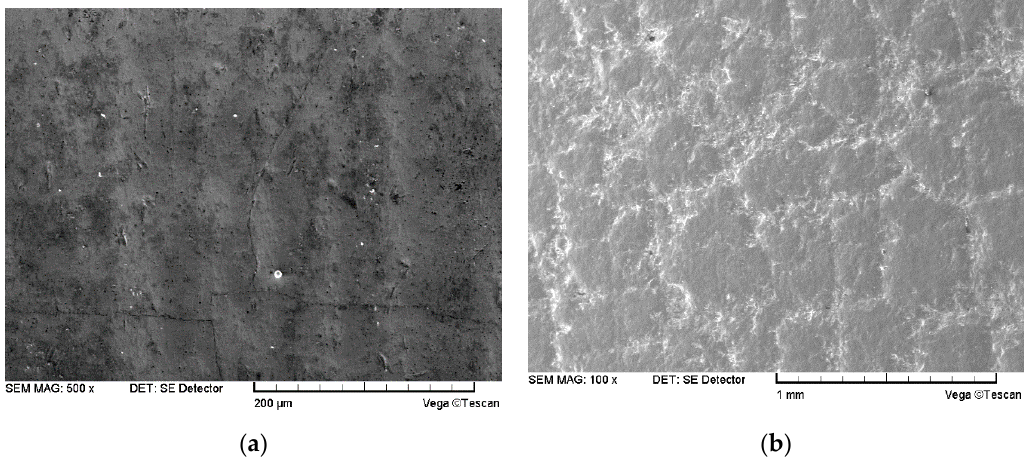
Figure 12. Comparison of the erosion morphology of the boronized coating at 210 m/s, 566 ℃ and 30° condition: ( a ) D 32 = 65 μ m; ( b ) D 32 = 336 μ m.